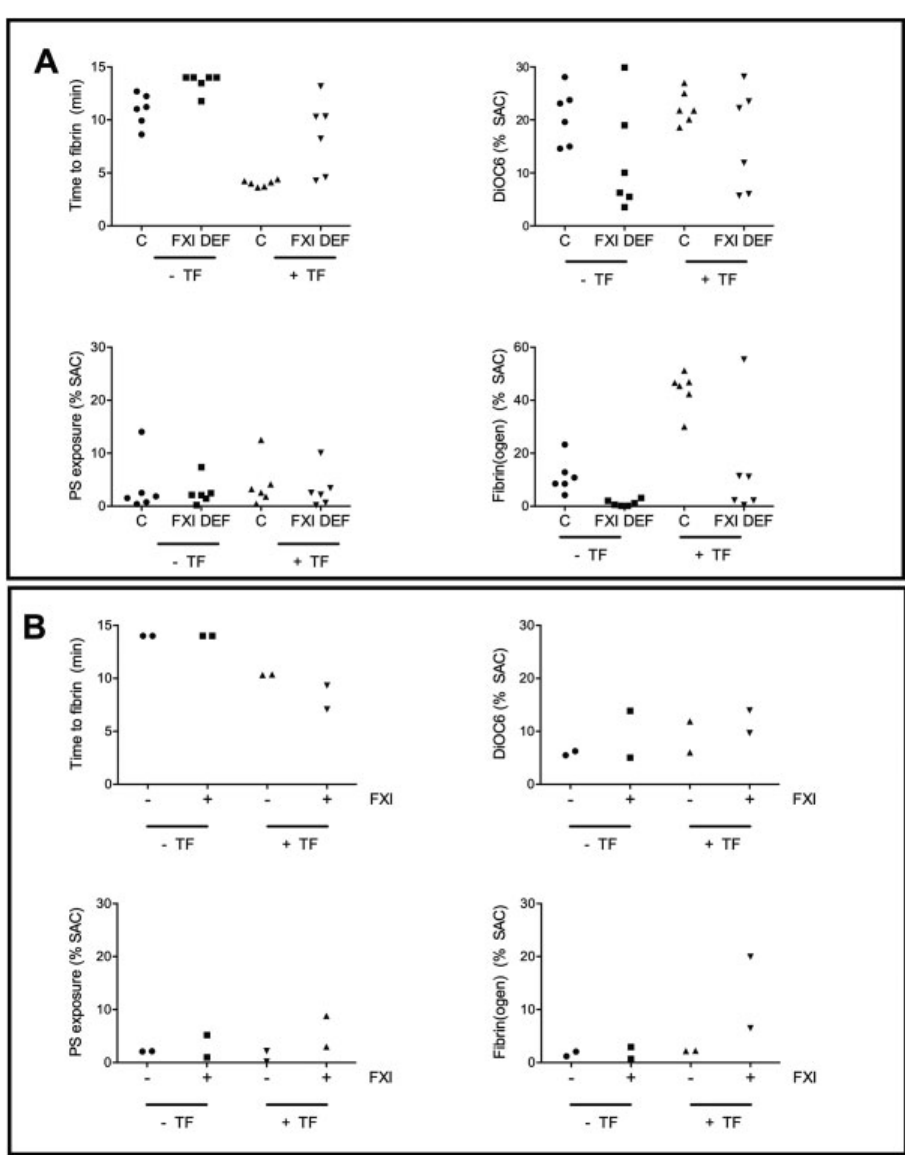
Fig. 4 Quanti fi cationof fi brin-thrombusformationinwholebloodfrompatientswithfactorXIde fi ciency.Wholebloodsamplesfromcontrolsubjectsand indicated FXI-de fi cient patients were perfused under recalci fi cation over microspots ofcollagen (cid:6) TF for 11minutes, as described for ► Fig. 3 . Microscopic images were analyzed for: time-to- fi rst fi brin formation, platelet deposition (DiOC 6 , %SAC), phosphatidylserine exposure (AF568-annexin A5, %SAC), and AF647- fi brin formation (%SAC) ( A ). Furthermore, blood samples from two FXI-de fi cient patients (4 or < 1IU/dL) were supplemented with puri fi ed FXI (5.2 pmol in 1,000µL) leading to an increase in the endogenous FXI concentration of 33IU/dL and used for the same perfusion assay. Microscopic images were again analyzed for: time-to- fi rst fi brin formation, platelet deposition (DiOC 6 ), phosphatidylserine (AF568-annexin A5), and AF647- fi brin formation ( B ). TF, tissue